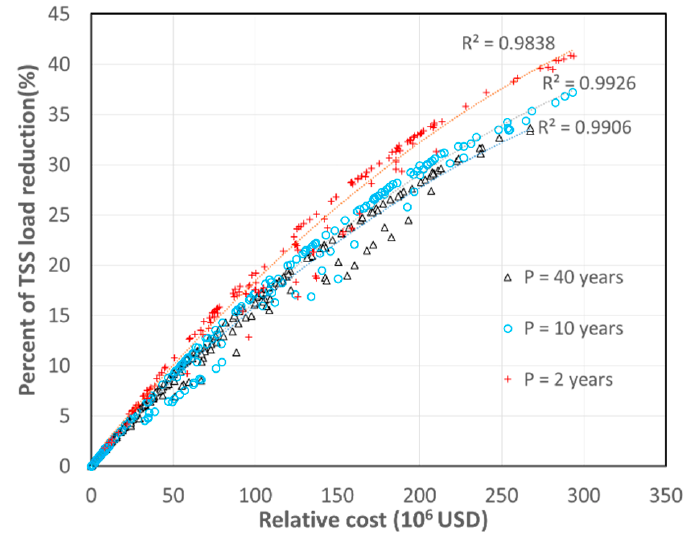
Figure 6. Comparison of the cost–e ff ectiveness curves with various designed storms. In order to quantify the deviation and median of the TSS removal e ffi ciency of sub-catchments with three return period rainfalls for three scenarios, we used box plots (Figure 7). The box plots indicate lower quartile, median, upper quartile, and interquartile range (IQR) of TSS removal e ffi ciency. Whiskers from each end of the box show the data range or, if smaller, the most extreme values within 1.5 times the interquartile range from the ends of the box. Outliers beyond the ends of the whiskers are marked with “o”. Here, the median of a box plot is considered to represent the nonlinear rate of the TSS removal e ffi ciency of a scenario, and IQR (Figure 8) as a measure of the strength of deviation of the TSS removal e ffi ciency in each scenario. The low, medium, and high scenarios correspond to optimal planning alternatives with respect to 10%, 20%, and 30% TSS removal e ffi ciencies at the outfall for the 2-year rainfall period. For all three scenarios, the median gradually declined when the return periods of the rainfalls increased from 2 to 40 years. The amount of reduction in the median induced by the increase in the return period of rainfall grew from low to high scenarios. Similarly, the trend of variation in the IQR against the increasing return periods of rainfalls was observed in low and medium scenarios as well. The IQR nearly kept at a stable level in the high scenario. Note that the IQR of the medium scenario reached the highest values among the three scenarios (Figure 8). Asymmetric distribution of the medium scenario could prove that higher priority of LID installation was given for sub-catchments with low TSS load. Conversely, symmetric distribution was observed for both the low and high scenarios, although several low outliers appeared in the high